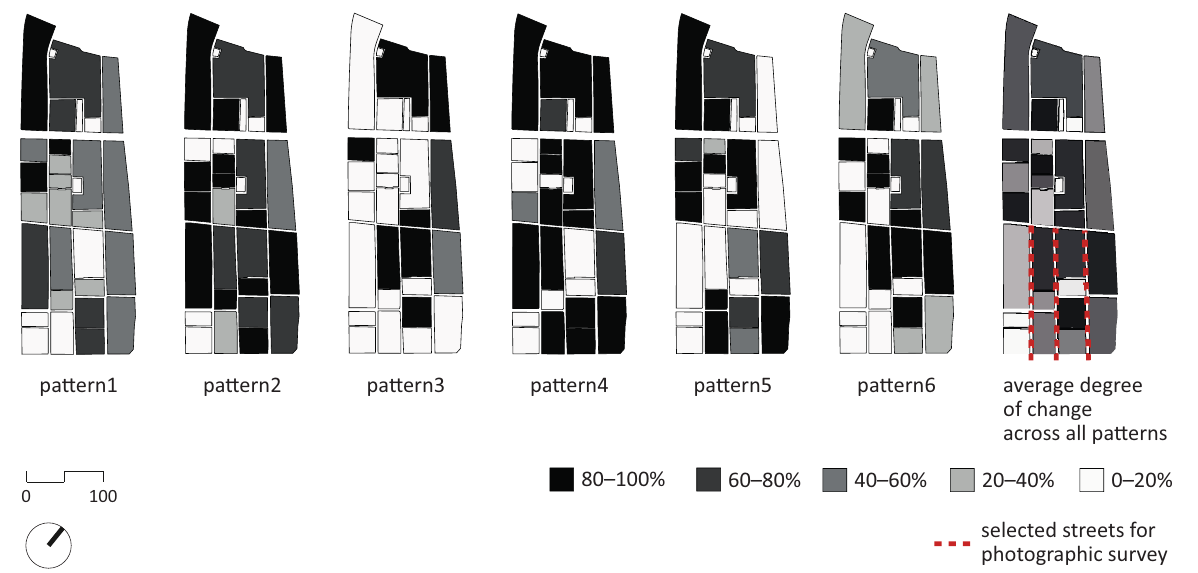
Figure 3. The degree of change.